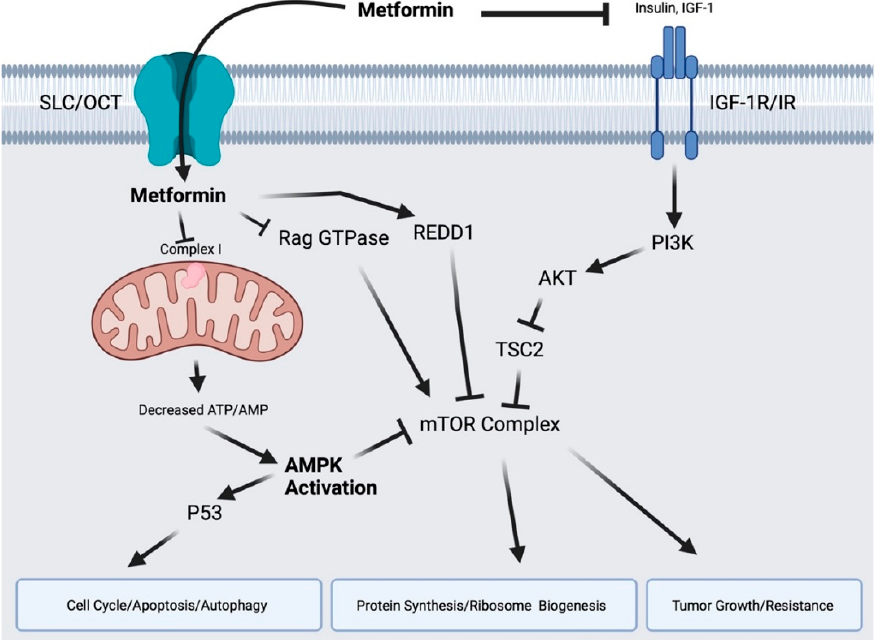
Figure 2. Molecular effects of metformin in cancer cells. Metformin directly inhibits complex I of the electron transport chain in the mitochondria resulting in decreased ATP/AMP ratio and activation of AMPK. AMPK activation inhibits mTOR and activates P53 to impact subsequent cellular processes. Metformin also inhibits mTOR in an AMPK-independent manner, through Rag GTPases and REDD1. Reduced insulin availability through metformin’s systemic effects indirectly modulates the proliferative pathway, PI3K/AKT. AMP: Adenosine Monophosphate; AMPK: AMP-Activated Protein Kinase; ATP: Adenosine Triphosphate; IGF: Insulin-like Growth Factors; IGF-R: Insulin-like Growth Factor Receptor; mTOR: Mammalian Target of Rapamycin; OTC: Organic Cation Transporter; PI3K: Phosphoinositide 3-kinase; REDD1: Regulated in Development and DNA damage responses 1; SLC: Solute Carrier Transporter; TSC2: Tuberous Sclerosis Complex 2. Created in BioRender.